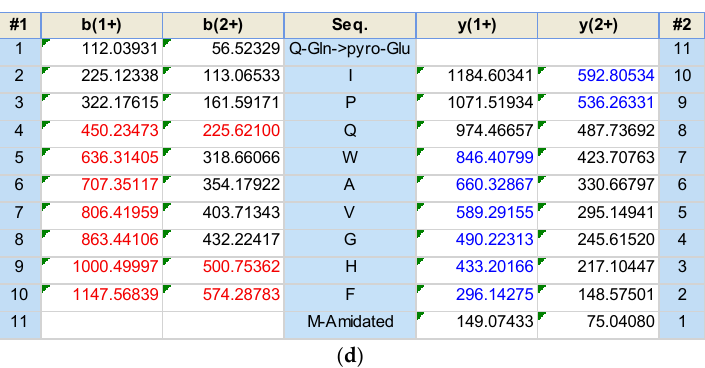
Table 1. Multiple comparisons of contractile activity of peptides (1 µM) on isolated tissues. The error term is Mean Square (Error) = 0.002. *. The mean difference is significant at the 0.05 level.